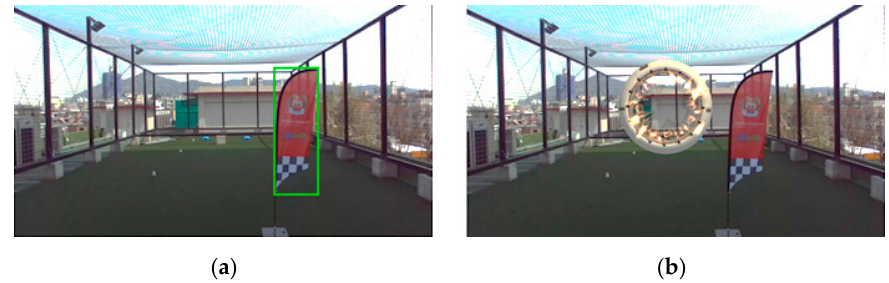
Figure 5. ( a ) A detected flag, ( b ) A created virtual ring next to the flag.